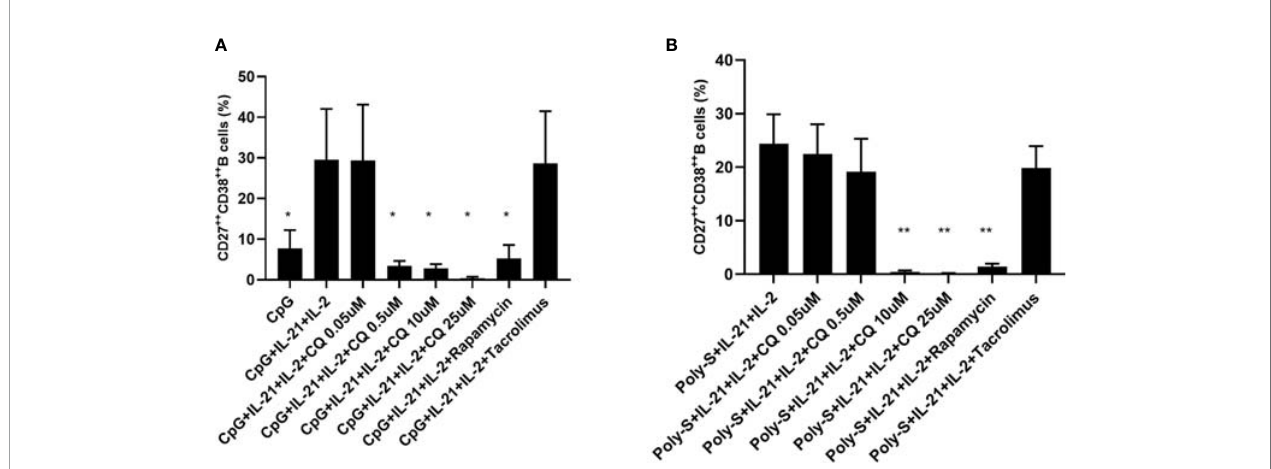
FIGURE 5 | Effect of CQ on plasmablast formation depending on the stimulus. Puri fi ed B cells were stimulated for 6 days and were monitored for differentiation into plasma cells by fl ow cytometry. (A) Impact of CQ on plasma cells upon CpG plus IL-21 and IL-2 stimulation. (B) Impact of CQ on plasma cells upon IgG+IgM plus IL-21 and IL-2 stimulation. P-values were calculated by repeated-measures ANOVA and correction for multiple comparisons were done by Dunnett ’ s test. *p < 0.05, **p < 0.001 (against CpG+IL-2+IL-21 or Poly-S+IL-2+IL-21 as control conditions).